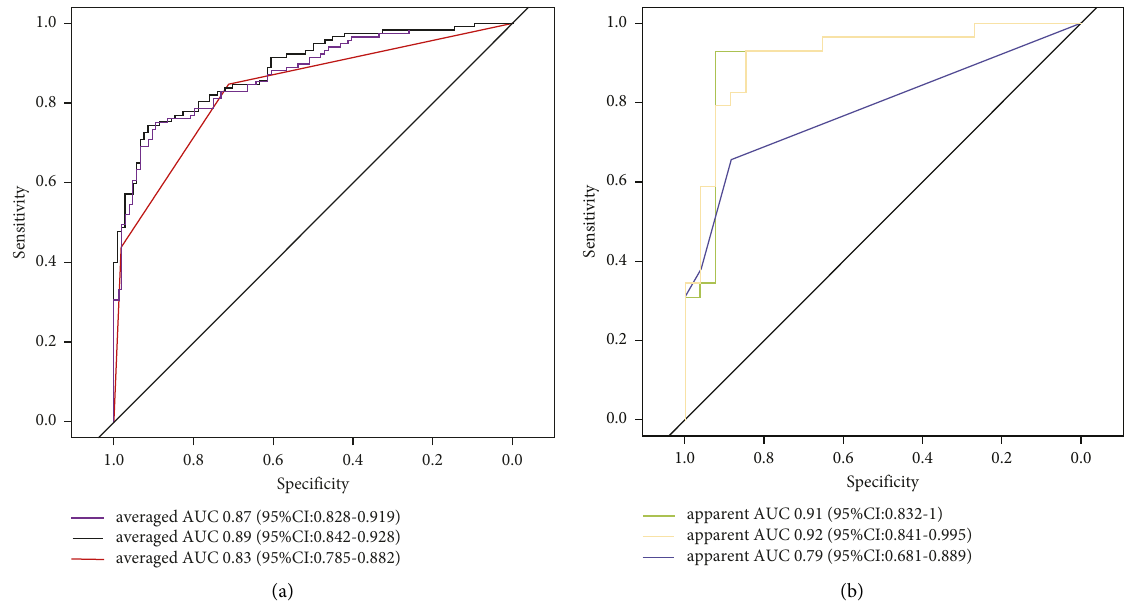
Figure 5: ROC curves of invasiveness predictive models. (a) Averaged ROC tested in 50 resamples of the training cohort using 5 repeats of 10-fold cross-validation. (b) ROC tested in our testing cohort. The purple and green lines are for the texture model, the black and orange lines are for the combined model, and the red and blue lines are for the semantic model.